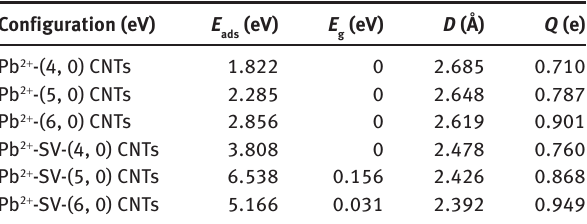
Table 1: The adsorption energy ( E the interaction distance ( D ), and the charge transfer from tubes to Pb ion ( Q ).